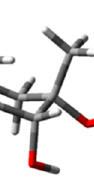
Figure 2. Comparison between experimental ECD spectrum of (-)- 1 (solid red line) and calculated ECD spectrum for (1 S ,2 R ,3 S ,4 R )- 1 (dotted blue line).